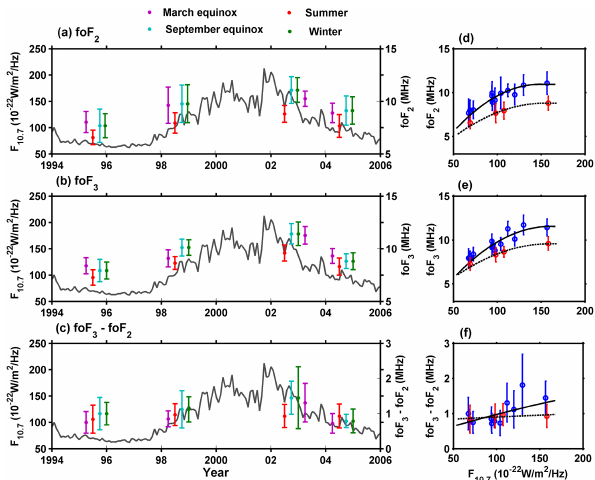
Figure 8. Seasonal mean and SD of (a) f o F 2 and (b) f o F 3 (c) f o F 3 – f o F 2 overlaid by F 10 . 7 to show solar activity depen- dence. Note the colors representing different seasons. Right side panels show correlations between (d) f o F 2 , (e) f o F 3 and (f) f o F 3 – f o F 2 with F 10 . 7 including the best fit lines. Data points shown in red correspond to summer since they are different from those ob- served in other